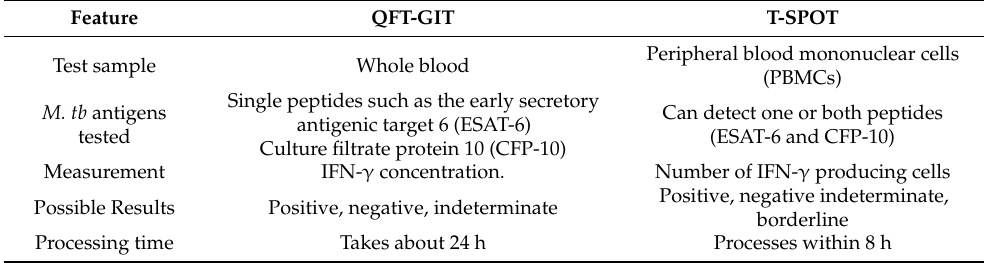
Table 1. Comparison between QFT-GIT and T-SPOT tests